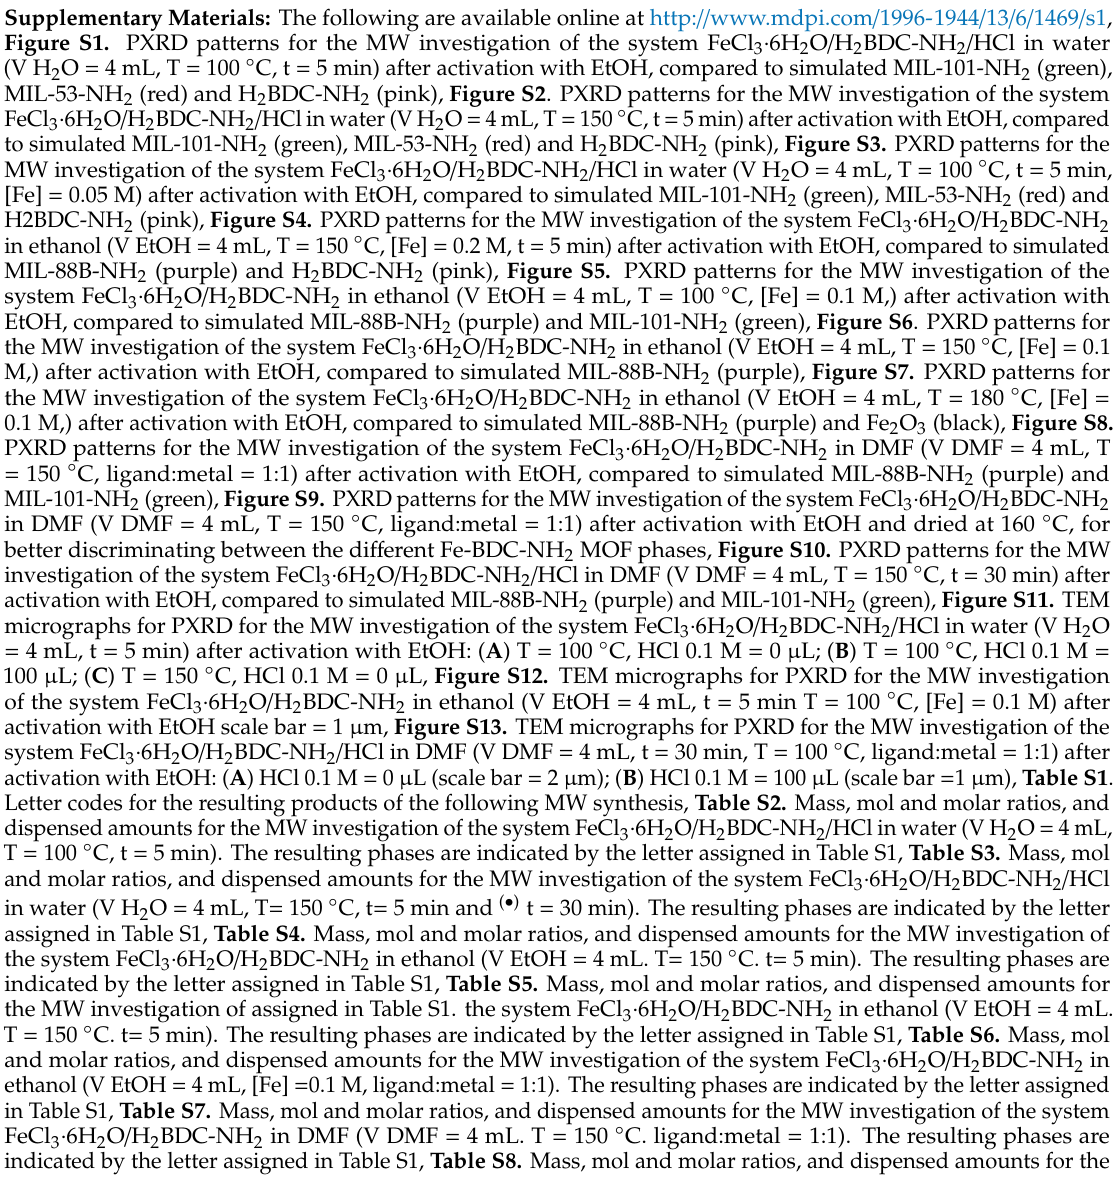
Figure S1. PXRD patterns for the MW investigation of the system FeCl 3 · 6H 2 O / H 2 BDC-NH 2 / HCl in water (V H 2 O = 4 mL, T = 100 ◦ C, t = 5 min) after activation with EtOH, compared to simulated MIL-101-NH 2 (green), MIL-53-NH 2 (red) and H 2 BDC-NH 2 (pink), Figure S2 . PXRD patterns for the MW investigation of the system FeCl 3 · 6H 2 O / H 2 BDC-NH 2 / HCl in water (V H 2 O = 4 mL, T = 150 ◦ C, t = 5 min) after activation with EtOH, compared to simulated MIL-101-NH 2 (green), MIL-53-NH 2 (red) and H 2 BDC-NH 2 (pink), Figure S3. PXRD patterns for the MW investigation of the system FeCl 3 · 6H 2 O / H 2 BDC-NH 2 / HCl in water (V H 2 O = 4 mL, T = 100 ◦ C, t = 5 min, [Fe] = 0.05 M) after activation with EtOH, compared to simulated MIL-101-NH 2 (green), MIL-53-NH 2 (red) and H2BDC-NH 2 (pink), Figure S4. PXRD patterns for the MW investigation of the system FeCl 3 · 6H 2 O / H 2 BDC-NH 2 in ethanol (V EtOH = 4 mL, T = 150 ◦ C, [Fe] = 0.2 M, t = 5 min) after activation with EtOH, compared to simulated MIL-88B-NH 2 (purple) and H 2 BDC-NH 2 (pink), Figure S5. PXRD patterns for the MW investigation of the system